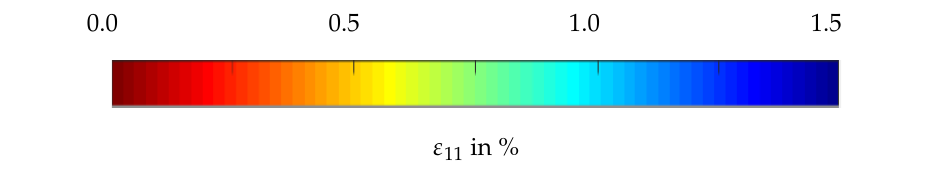
Figure A1. Legend for the following contour plots.